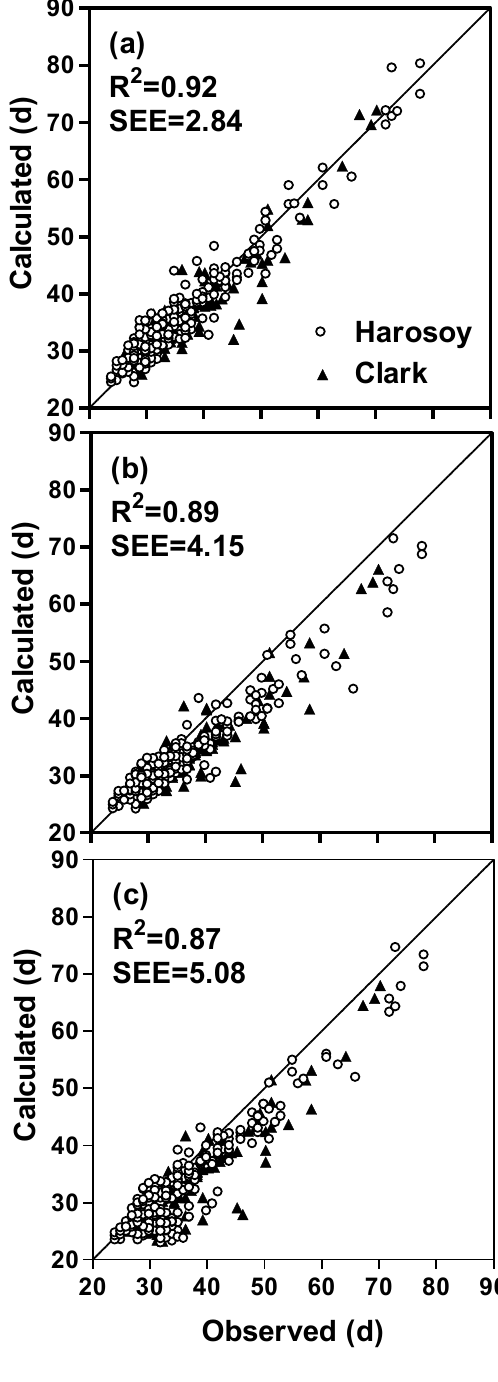
Figure 9. A comparison of calculated and observed days from planting to first flower for Harosoy and Clark soybean isolines for ( a ) the complete multiplicative model, ( b ) the complete model without the rate of photoperiod change function, ( c ) the complete model without the irradiance